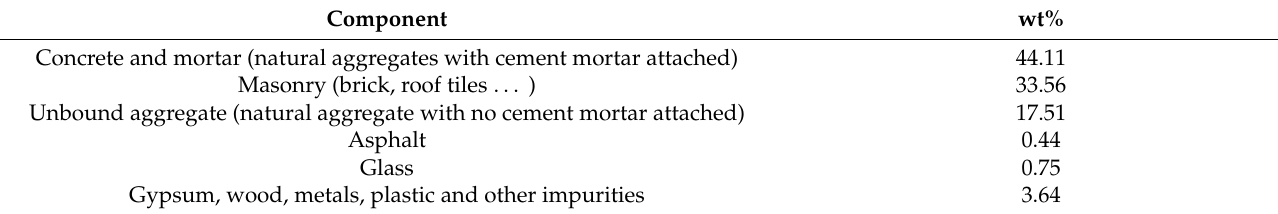
Table 3. Non-floating components in recycled aggregate.